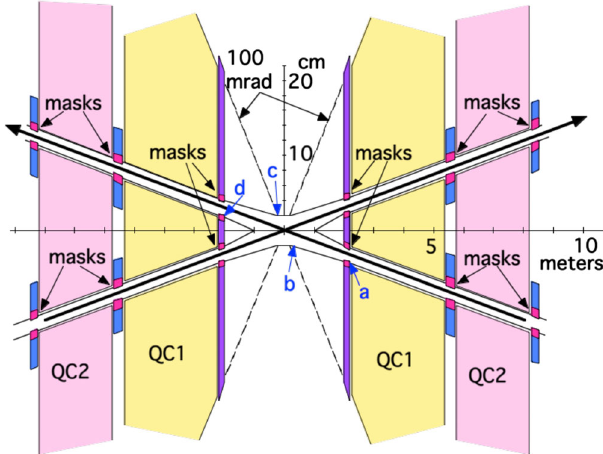
FIG. 1. View of the FCC-ee IR layout (cid:3) 10 m from IP. The QC1 and QC2 final focus quadrupoles are drawn in yellow and pink; the a,b,c,d locations are defined. Between QC1 and QC2 there are SR masks (blue and